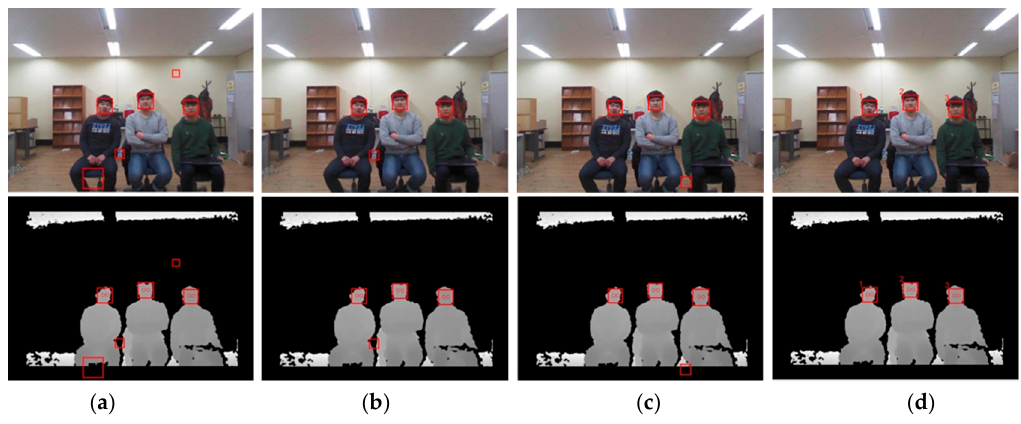
Figure 9. Comparing the detection accuracy of the proposed and benchmark algorithms at a distance of 2.5 m from the RGB and depth cameras (top: RGB image; bottom: depth image): ( a ) Algorithm 1; ( b ) Algorithm 2; ( c ) Algorithm 3; and ( d ) proposed algorithm.